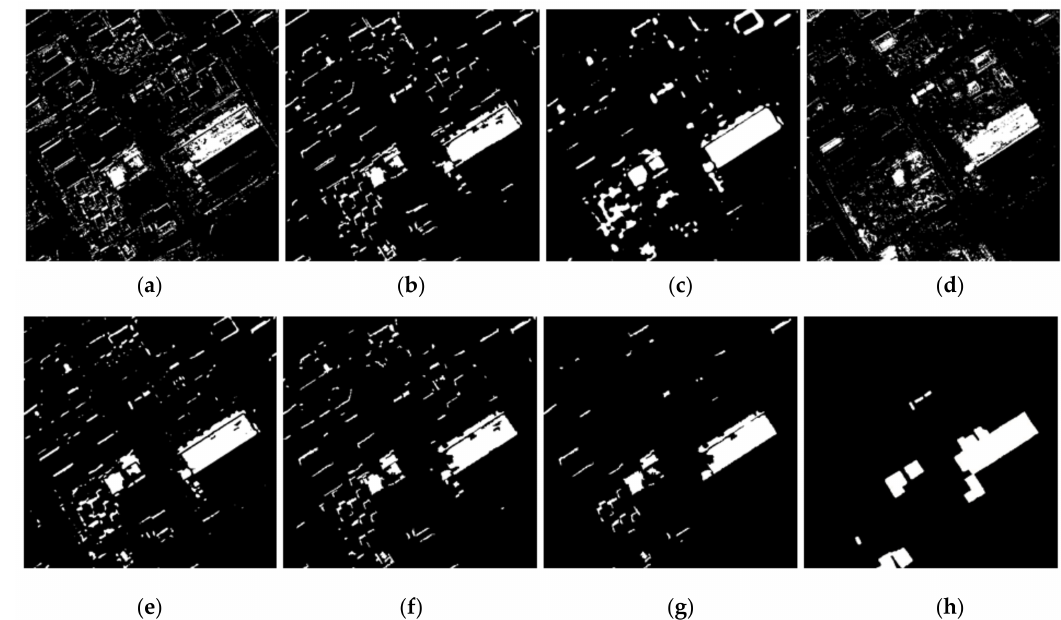
Figure 14. Binary change maps of B&T sample 2 generated by different methods: ( a ) CVA; ( b ) OCVA;